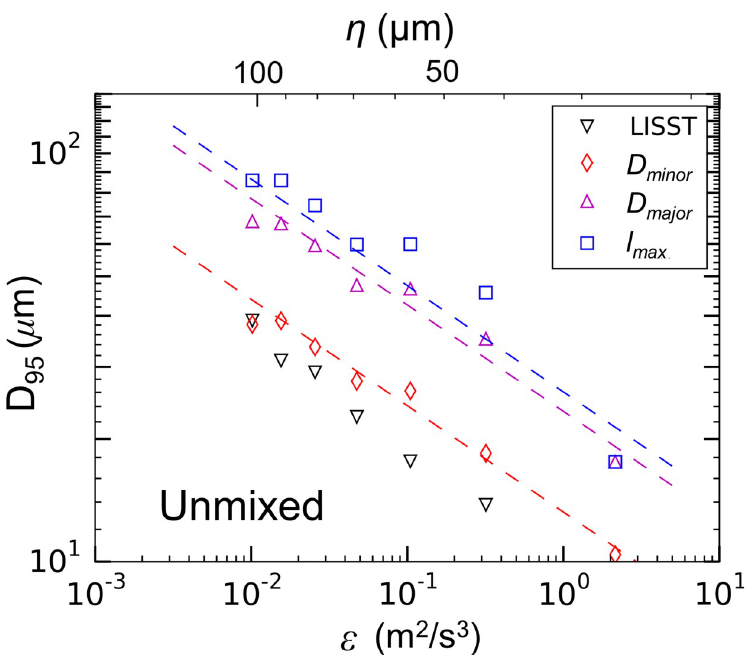
Fig 14. Floc strength curves plotted with lengthscales obtained from the LISST and from the image analysis for an unmixed aggregation tank.